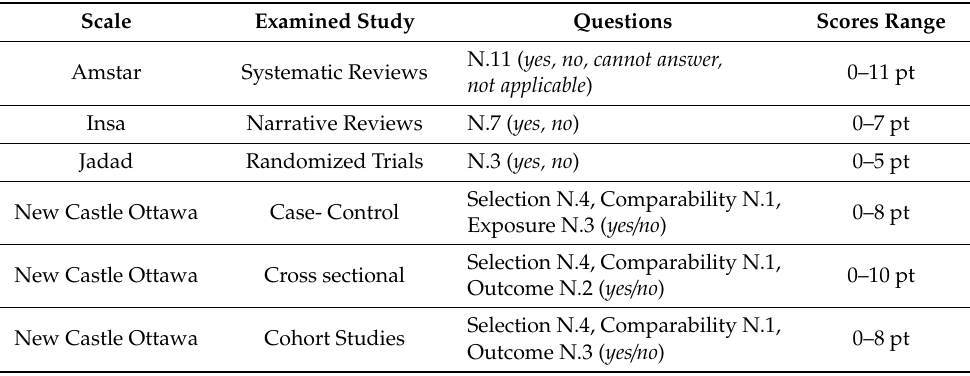
Table 1. Tools for assessing the quality of studies included in this systematic